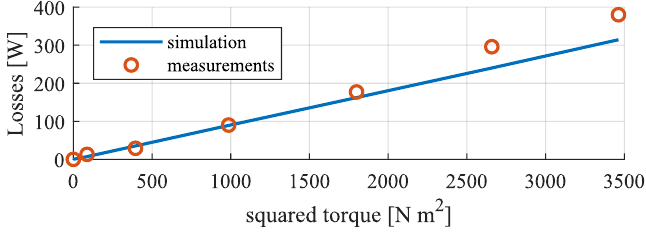
Figure 19. Comparison between measurements and simulations about on-load additional losses. The motor under test is the IEC 132, stack length 200mm and P n =